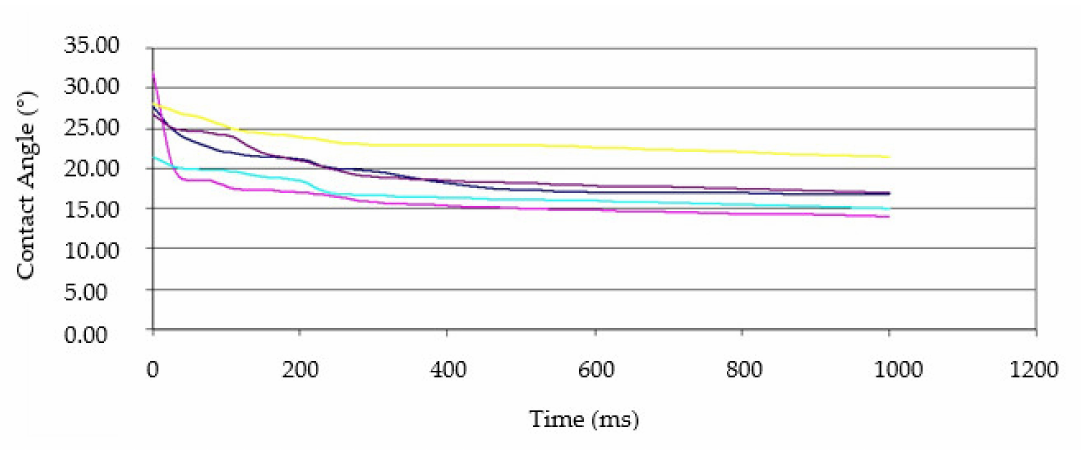
Figure 4. Example of the results of diiodomethane contact angle changes on the modified surface of five